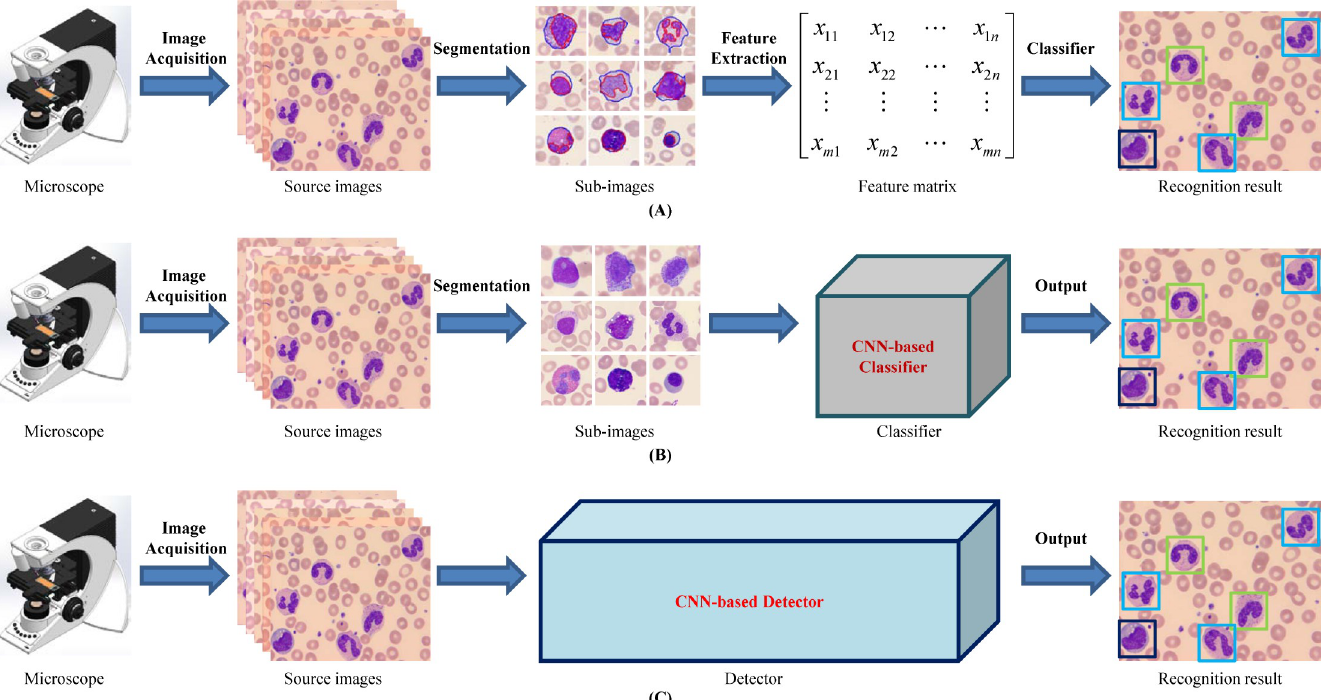
Fig 1. Pipelines of peripheral leukocyte recognition. (A) treat leukocyte recognition as traditional feature engineering: segmentation, feature extraction & selection by manual and then classifier based on the feature matrix; (B) treat leukocyte recognition as object classification: get patches containing leukocyte candidates from original image by manual or segmentation approaches, and then feed these patches into CNN-based deep learning classifier to output the leukocyte types; (C) treat leukocyte recognition as object detection: feed the original images into CNN-based deep learning detector, and then output the leukocyte types and the corresponding locations.